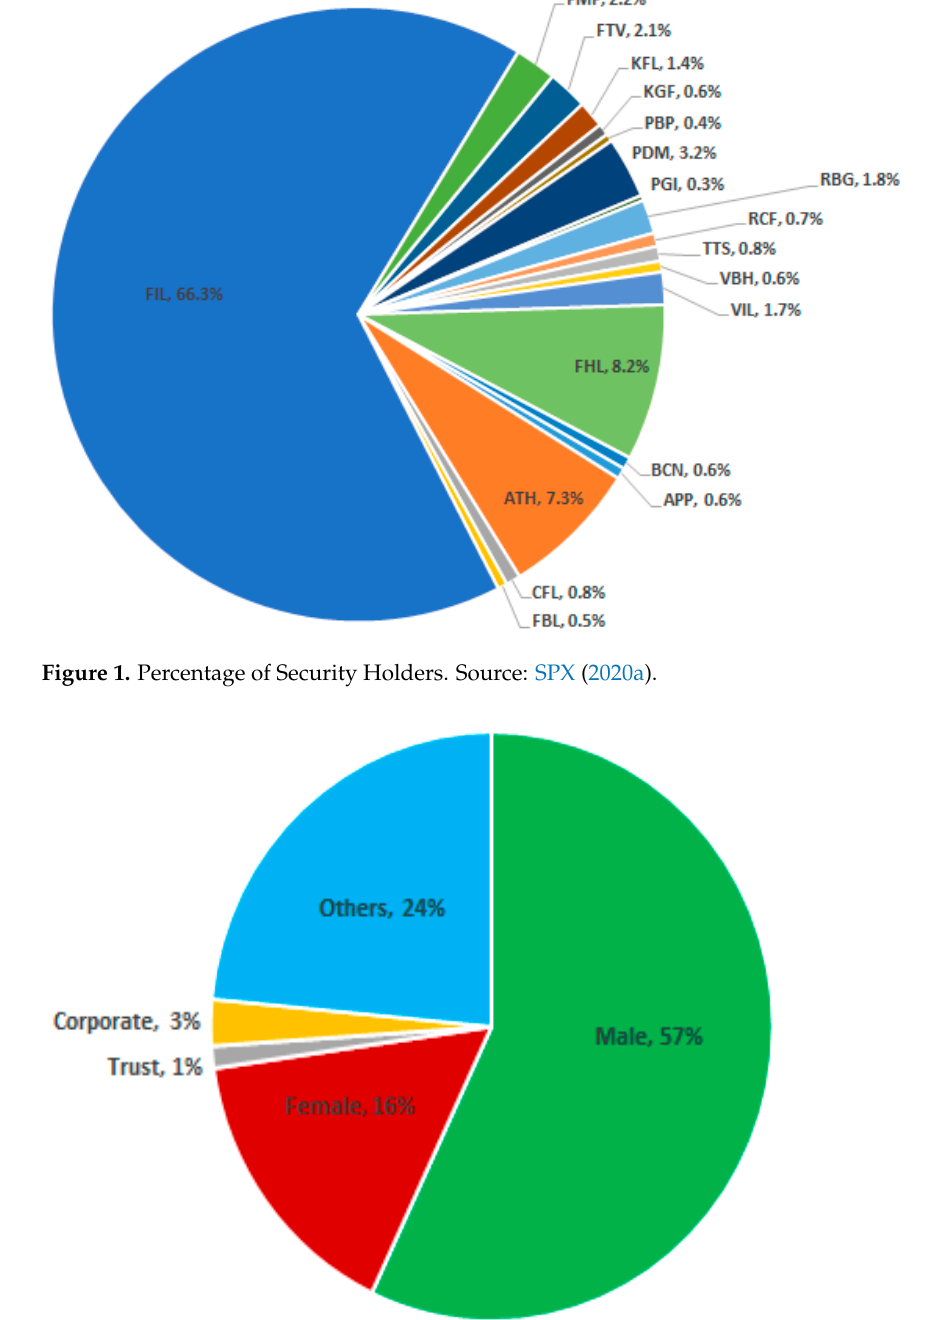
Figure 2. Percent of Resident Security Holders by Investor Type and Gender. Source: SPX (2020a).